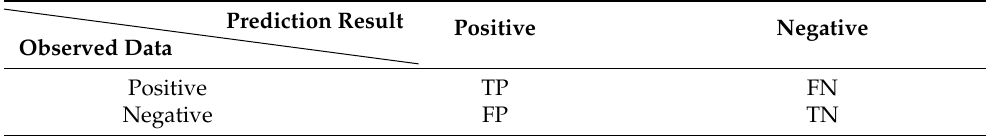
Table 2. The definitions of TP, TN, FP, and